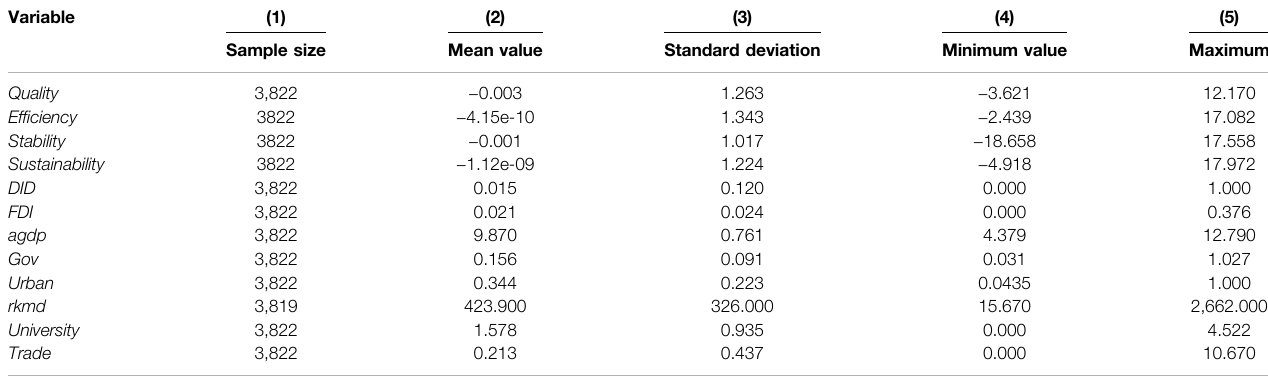
TABLE 3 | Summary of descriptive